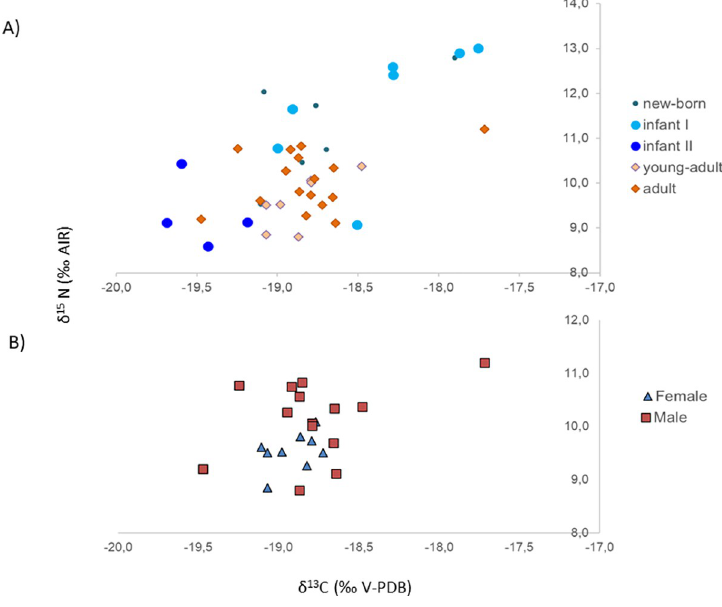
Fig 5. Plot of human bone collagen δ 13 C and δ 15 N values from Vila de Madrid sorted by (A) age groups and (B) sex -only from young adults and adults-.